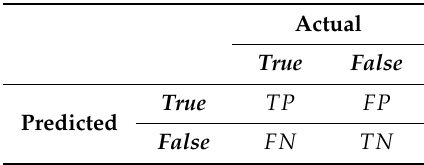
Table 4. An illustration of a confusion